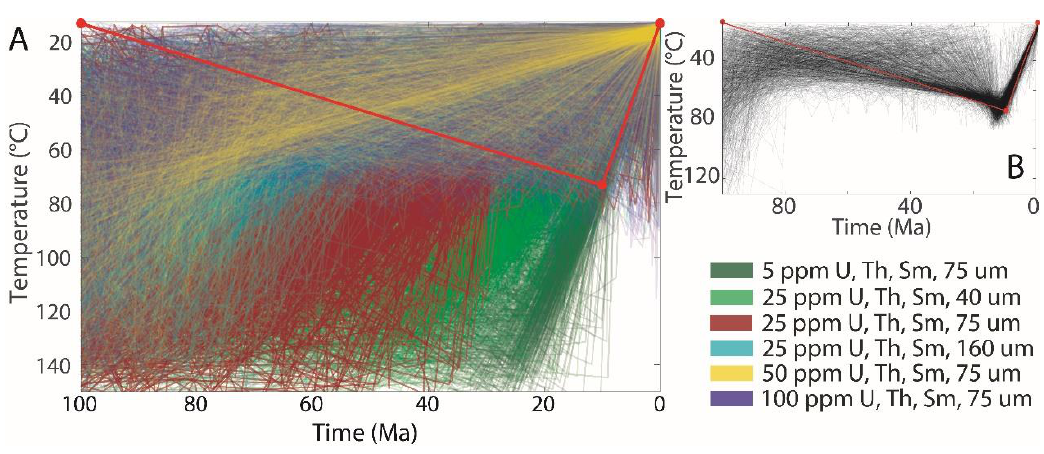
Figure 1. Thermal model results for the synthetic data described in the text and listed in Table 1. ( A ) Post “burn in” accepted thermal histories for each grain (by color). ( B ) Post “burn in” accepted thermal histories for aggregate model of all six grains in black. Original thermal history imposed in HeFTy forward model is shown in red on both A and B.